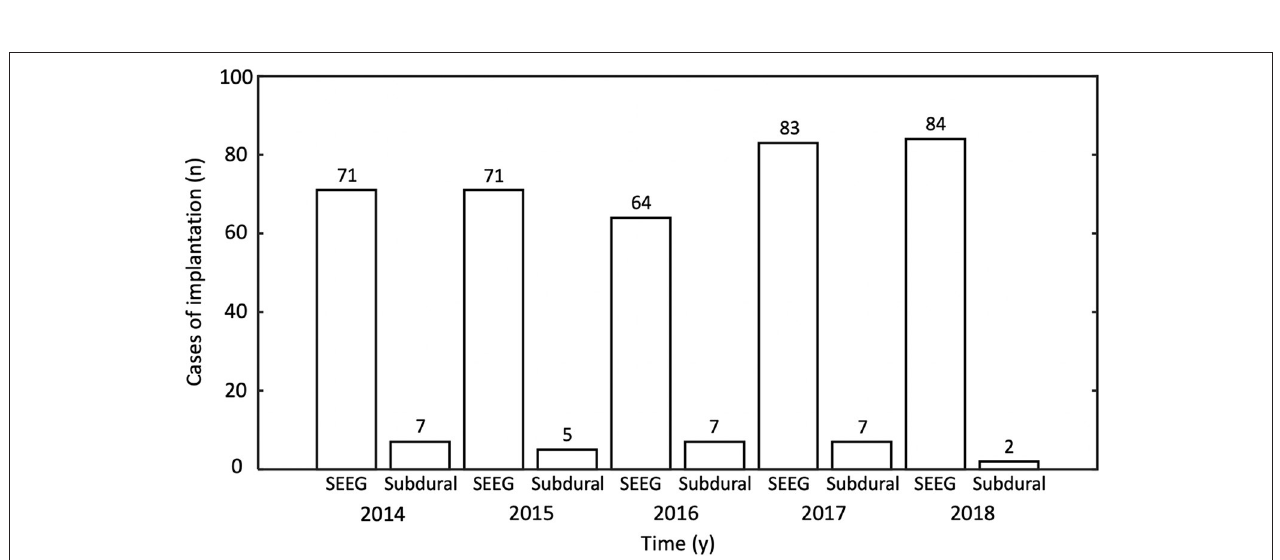
FIGURE 6 | Number of intracranial EEG (ICEEG) studies after multimodal image integration was performed, tabulated by year and type of ICEEG. y, year; SEEG, stereo-EEG.